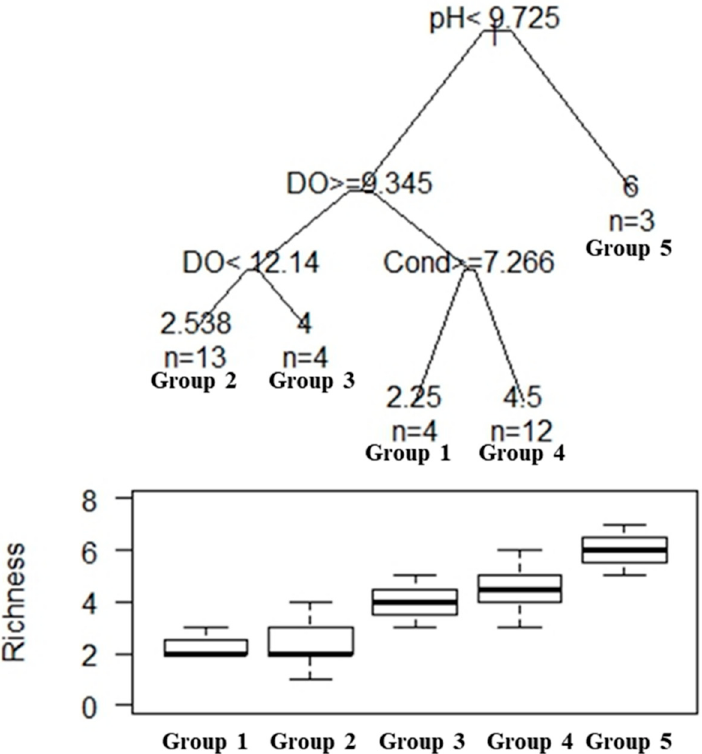
Figure 3. Regression tree of environmental variables on cladoceran richness of dune ponds. The pond without cladocerans was excluded from the analysis. Table 2. Species richness estimation based on the observed species presence/absence